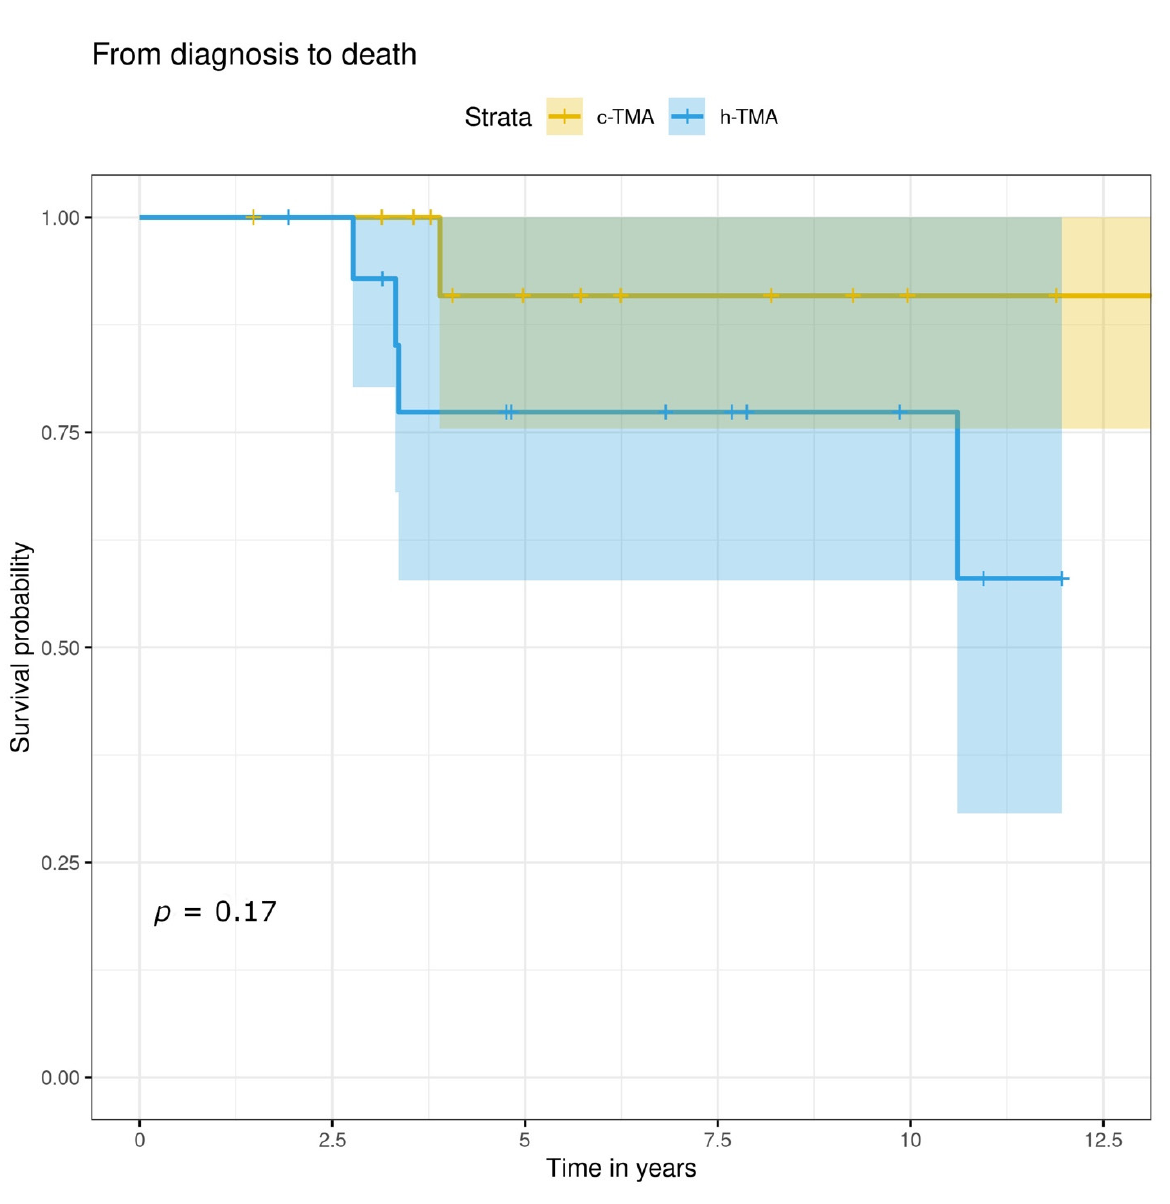
Figure 4. Kaplan–Meier curve on patient survival from diagnosis to death with c-TMA and h-TMA patients.